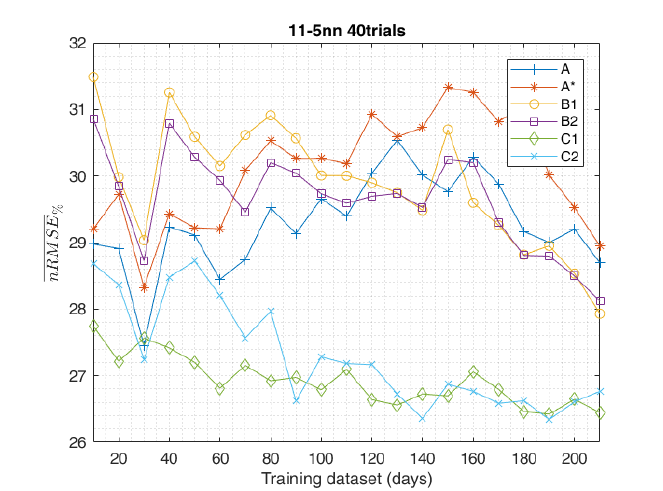
Figure 16. nRMSE % as a function of the dataset size.